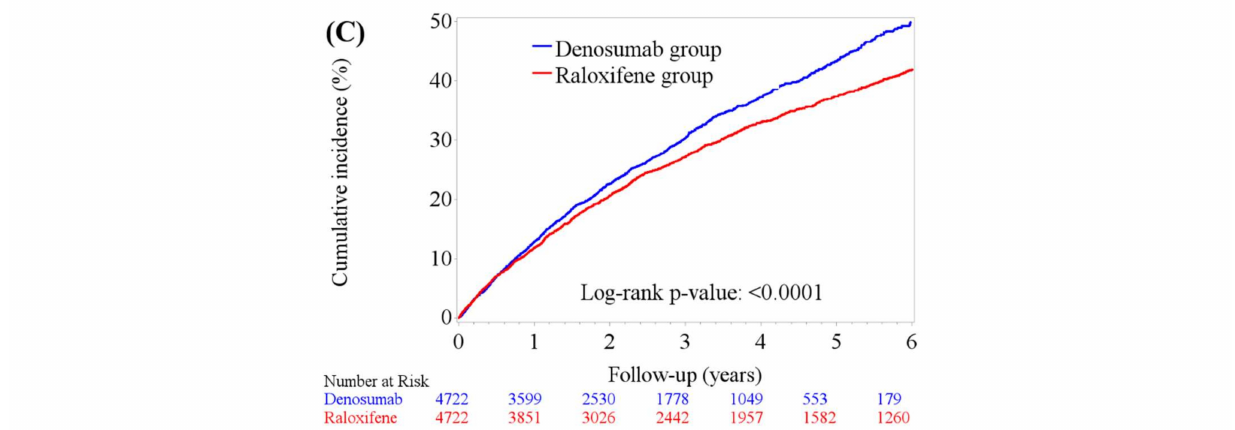
Figure 2. Cumulative incidence of kidney outcomes in the denosumab and raloxifene groups. ( A ) Any AKI event (log-rank test, p = 0.3668); ( B ) advanced AKI (KDIGO stage 2, 3 and dialysis)